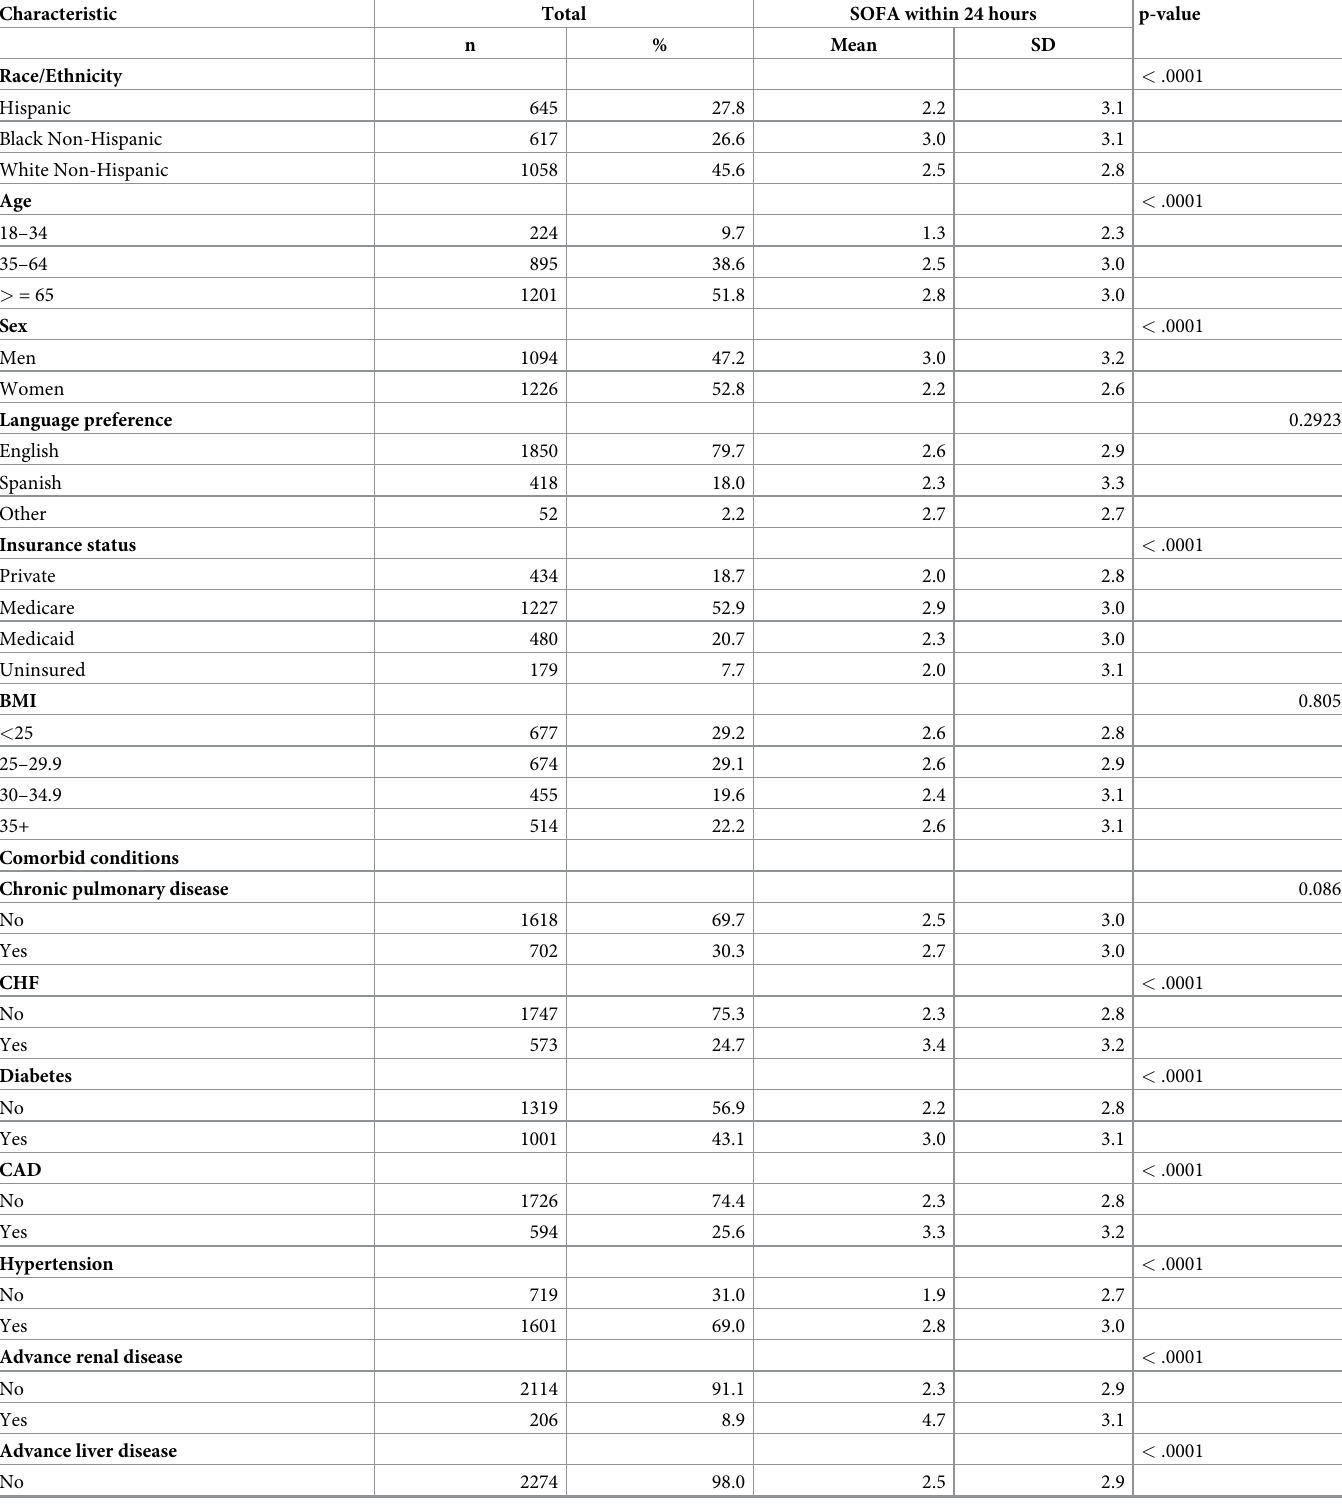
Table 3. Mean SOFA within 24 hours of